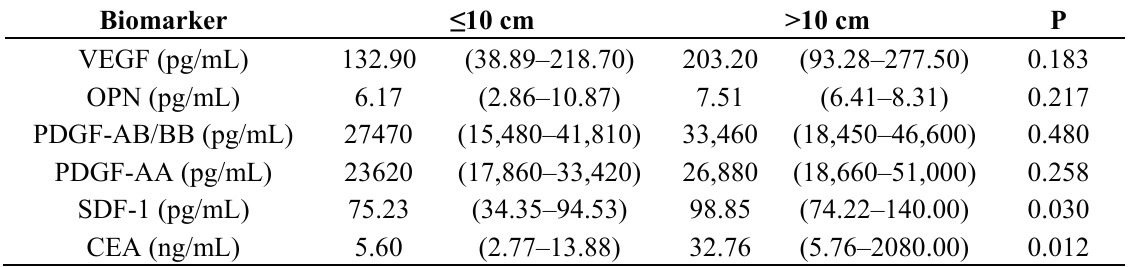
Table 3. Biomarker distributions at baseline according to disease